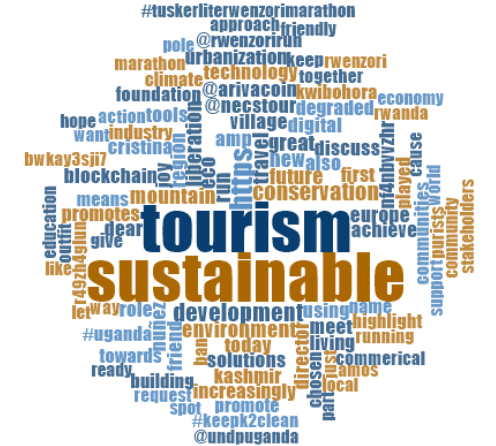
Figure 1. Lexicon cloud analysis map of sustainable